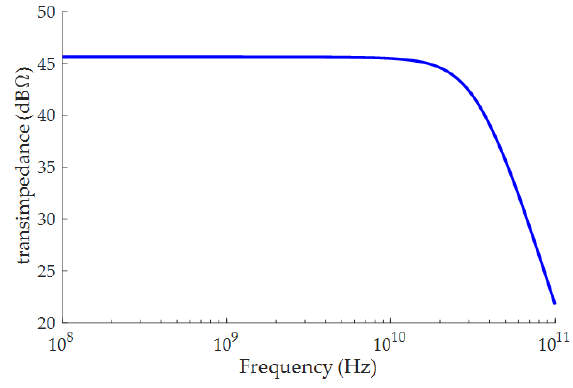
Figure 6. The simulated frequency response of the input TIA.